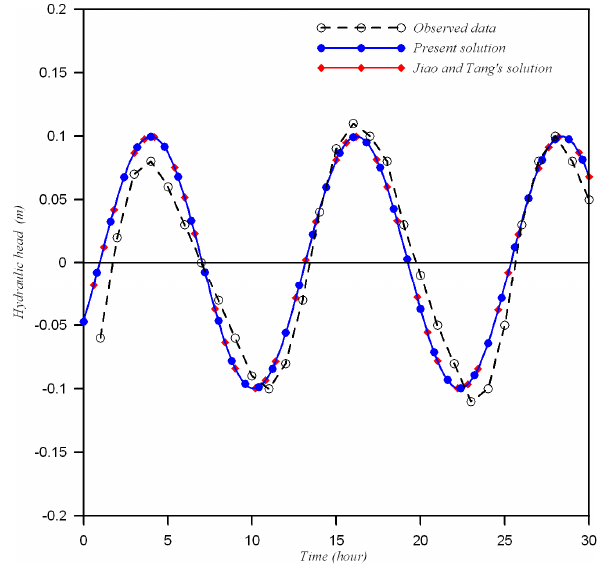
Figure 9. Predicted hydraulic heads by the present solution and Jiao and Tang’s solution 2 Fig. 9. Predicted hydraulic heads by the present solution and Jiao and Tang’s (1999) solution and the observed data measured at the (1999) and the observed data measured at the CLK airport, Hong Kong 3 CLK airport, Hong